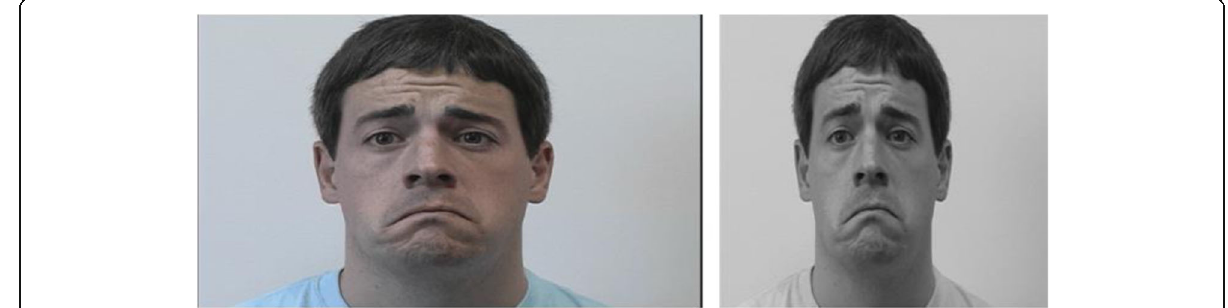
Fig. 5 Grayscale and resizing to 256 × 256